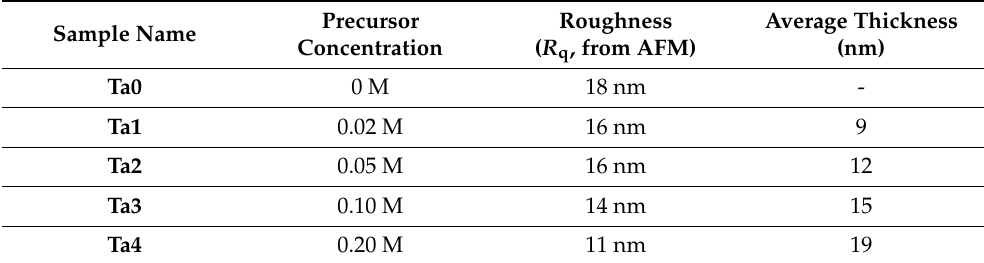
Figure 1. Morphology of Ta1 using scanning electron microscopy (SEM) at ( a ) low and ( b ) high magnifications, ( c ) 3D topography using AFM and ( d ) SEM of the Ta 2 O 5 film on the silicon substrate. Table 1. Roughness and thickness values of tantalum oxide films deposited on FTO and silicon,